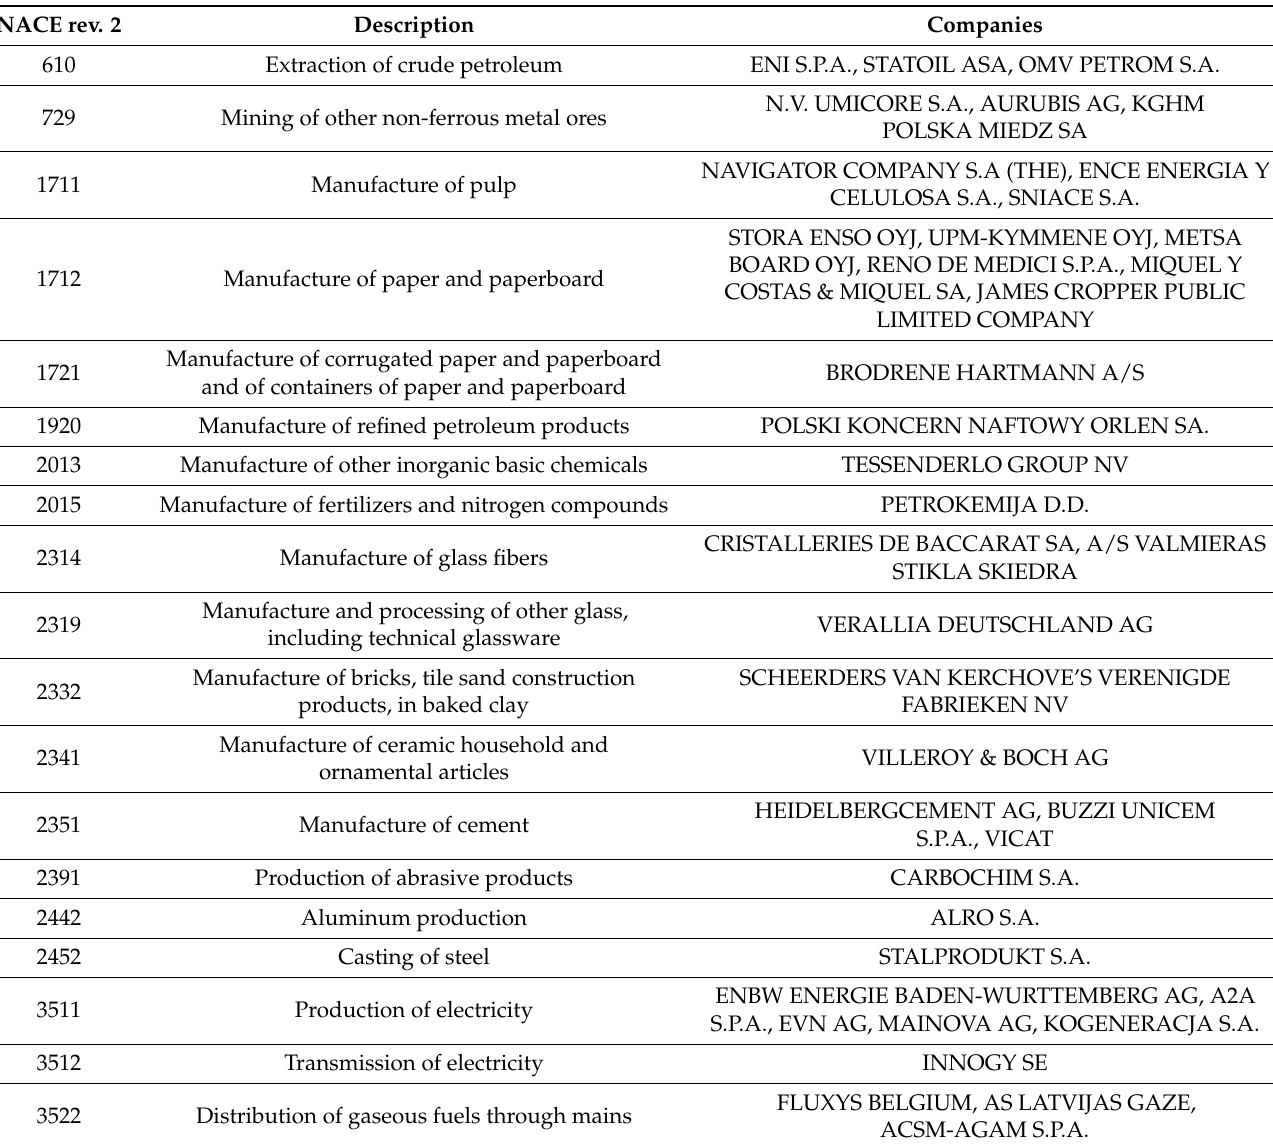
Table A1. Classification of the research